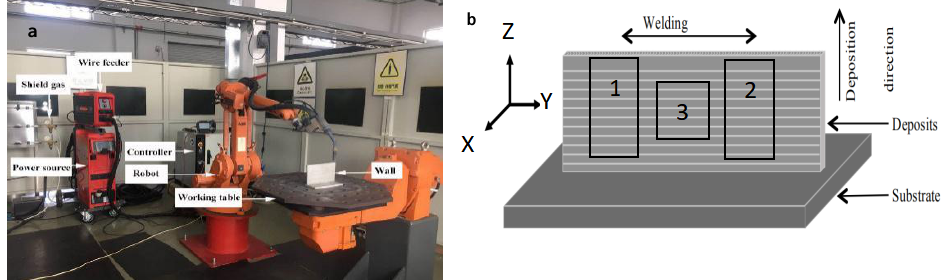
Figure 1. ( a ) Additive manufacture system and ( b ) definition of coordinates for Figure 1. ( a ):Additive manufacture system and ( b ):definition of coordinates for wall.